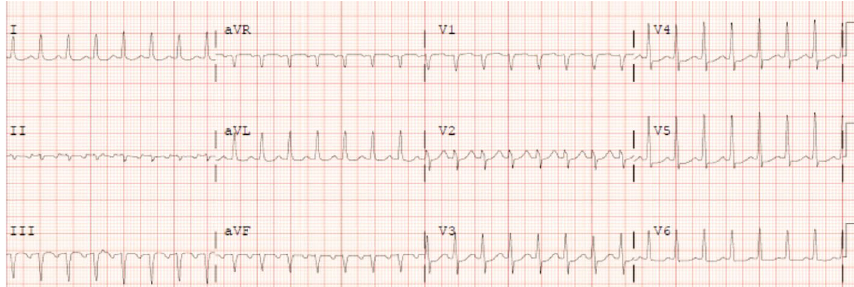
Figure 1: Initial EKG showing supraventricular tachycardia with heart rate of 181 beats per minute.